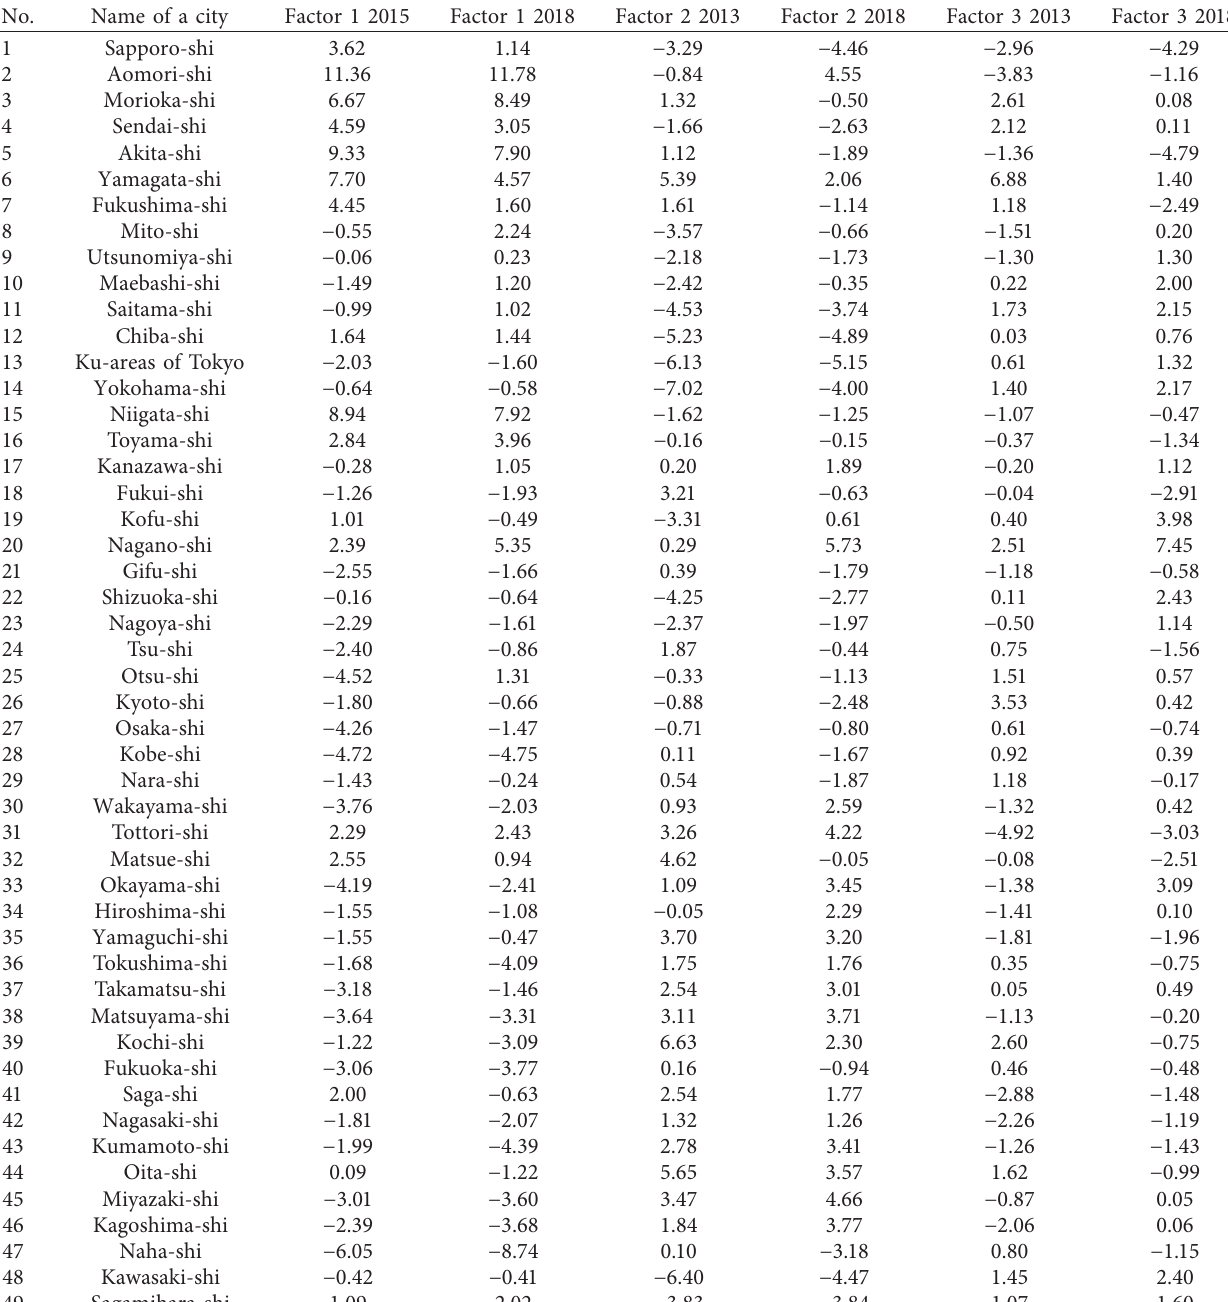
Table 5: Loading scores of cities in dietary patterns (Factors 1 to 3) identified using partial least squares regression analysis. No. Name of a